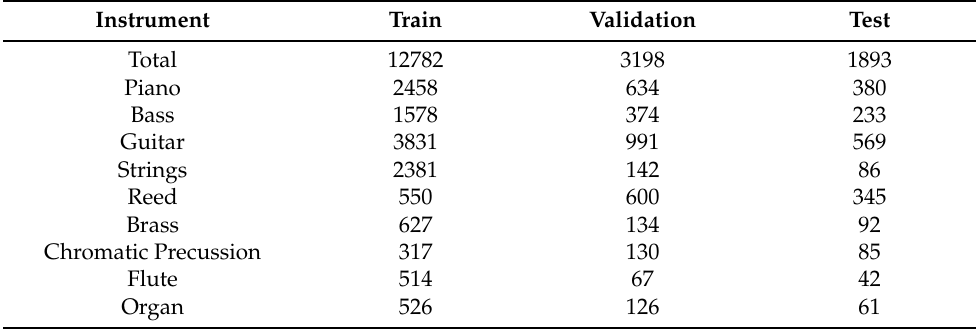
Table 1. Train, validation and test splits in Slakh2100